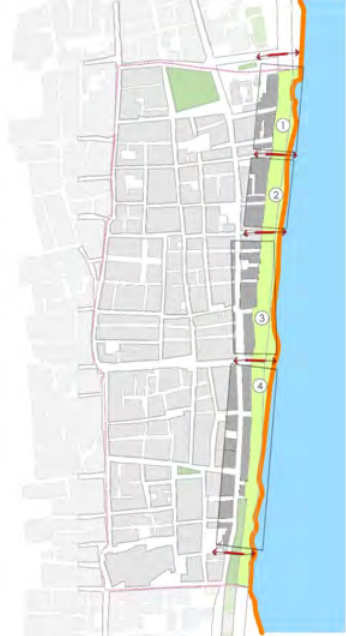
Figure 16. (Urban spaces Network)